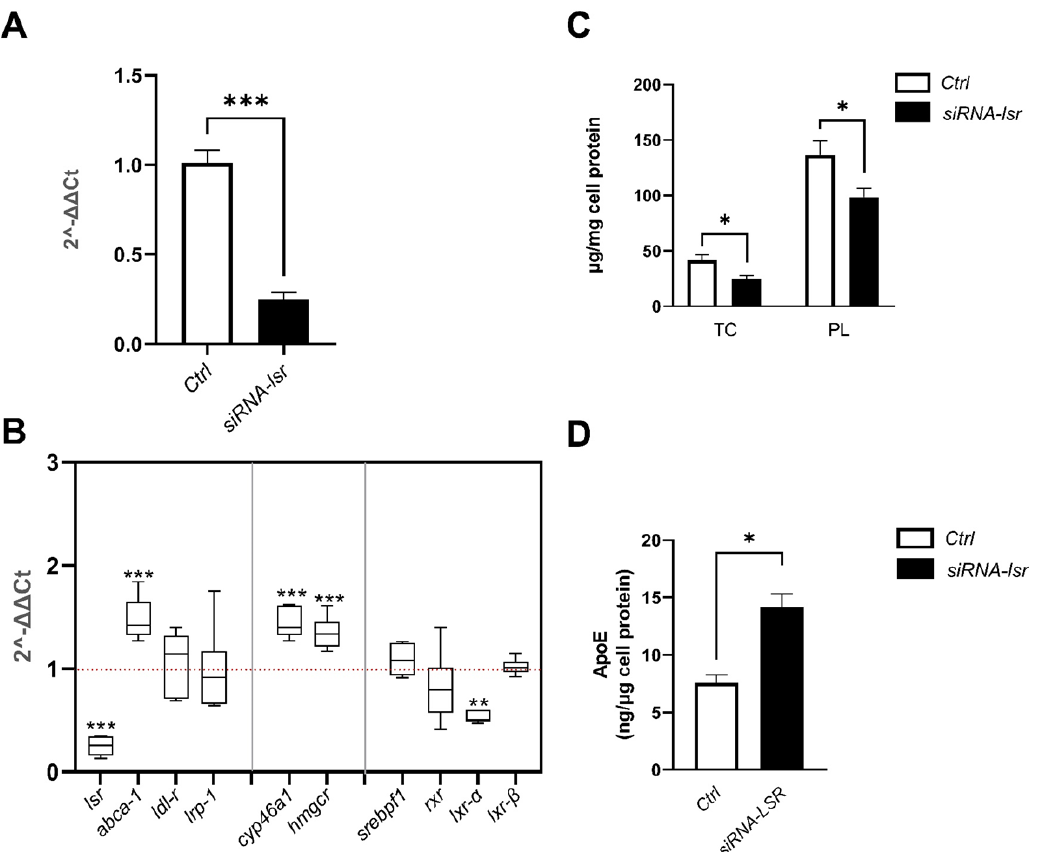
Figure 1. Effect of siRNA-mediated knockdown of lsr on cellular cholesterol homeostasis of murine astrocytes expressing human ApoE3. Astrocytes were treated with siRNA targeting lsr (siRNA- lsr ) or siRNA negative control (Ctrl) as described in the Materials and Methods. After 5 days incubation at 37 °C, cells and media were removed and stored for RT-qPCR of target genes, and assays of cell cholesterol and human ApoE in media. ( A ) qPCR analysis of lsr mRNA levels; ( B ) qPCR analysis of target genes indicated; ( C ) cell total cholesterol (TC) and phospholipid (PL) levels; ( D ) ApoE levels secreted in the cell media expressed per mg cell protein. Results are shown as mean ± SEM ( n = 12 per group). Statistical differences are shown as: * p < 0.05, ** p < 0.01, *** p < 0.001 (abbreviations: abca1 , ATP binding cassette transporter A1; cyp46a1 , cytochrome P450 family 46 subfamily A member 1; hmgcr , 3-hydroxy-3-methylglutaryl-CoA reductase; ldl-r : low-density lipoprotein-receptor; lrp-1 , LDL-R related protein 1; lxr , liver X receptor; rxr , retinoid X receptor; srebpf1 , sterol regulatory element binding protein 1).